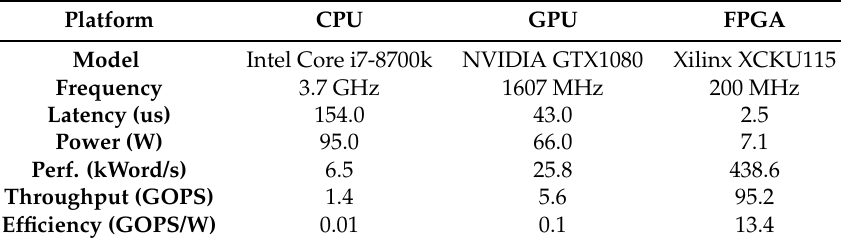
Table 10. Performance comparison between different